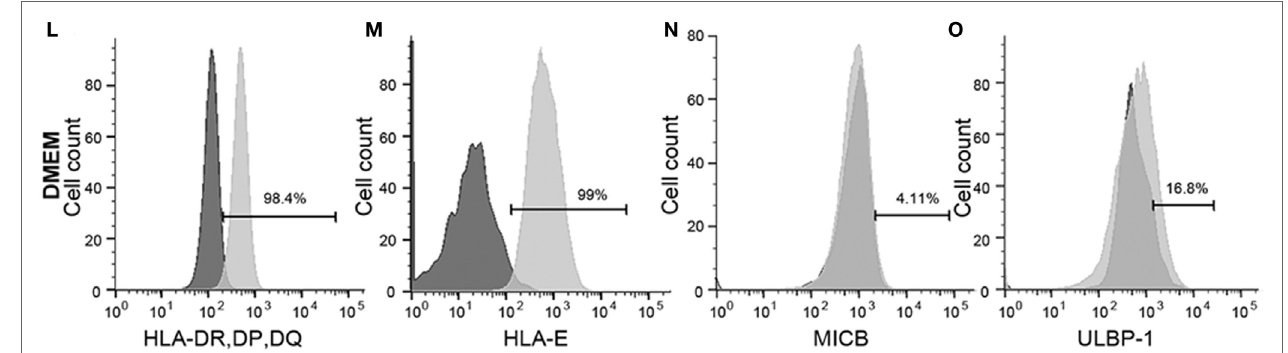
FigUre 4 | Undifferentiated glioblastoma (GBM) cells are more susceptible to natural killer (NK) cell lysis. Comparison of % lysis by NK cells of P3 (gray), 2012-018 (black), BG7 (blue), and BG5 (green) GBM cells cultured in (a) NB or (B) Dulbecco’s modified eagle medium (DMEM) media at E:T ratios 5:1, 10:1, and 20:1.% lysis by NK cells of (c) P3, (D) BG7, (e) BG5, and (F) 2012-018 GBM cells cultured in DMEM (gray) or NB (black) media at E:T ratios 5:1, 10:1, and 20:1. Data represent mean ± SEM of n = 3 independent experiments per GBM patient-derived cell line. Two-way ANOVA, Bonferroni’s multiple comparison test, * P < 0.05; ** P < 0.01; *** P < 0.001. (g) Gating strategy for cytotoxicity analyses showing dot plots (from left to right): cells, single cells, separation of effector (NK cells), and target (GBM cells) cells, and live/dead segregation of effector and target cells. Histograms showing surface expression % of (h) human leukocyte antigen-DR, DP, DQ on P3, (i) HLA-E on BG7, (J) MICB on BG5, and (K) ULBP-1 on 2012-018 GBM cells cultured in NB and (l–O) in DMEM, respectively. Dark gray histograms— fluorescent minus one control and light gray histogram—expression of